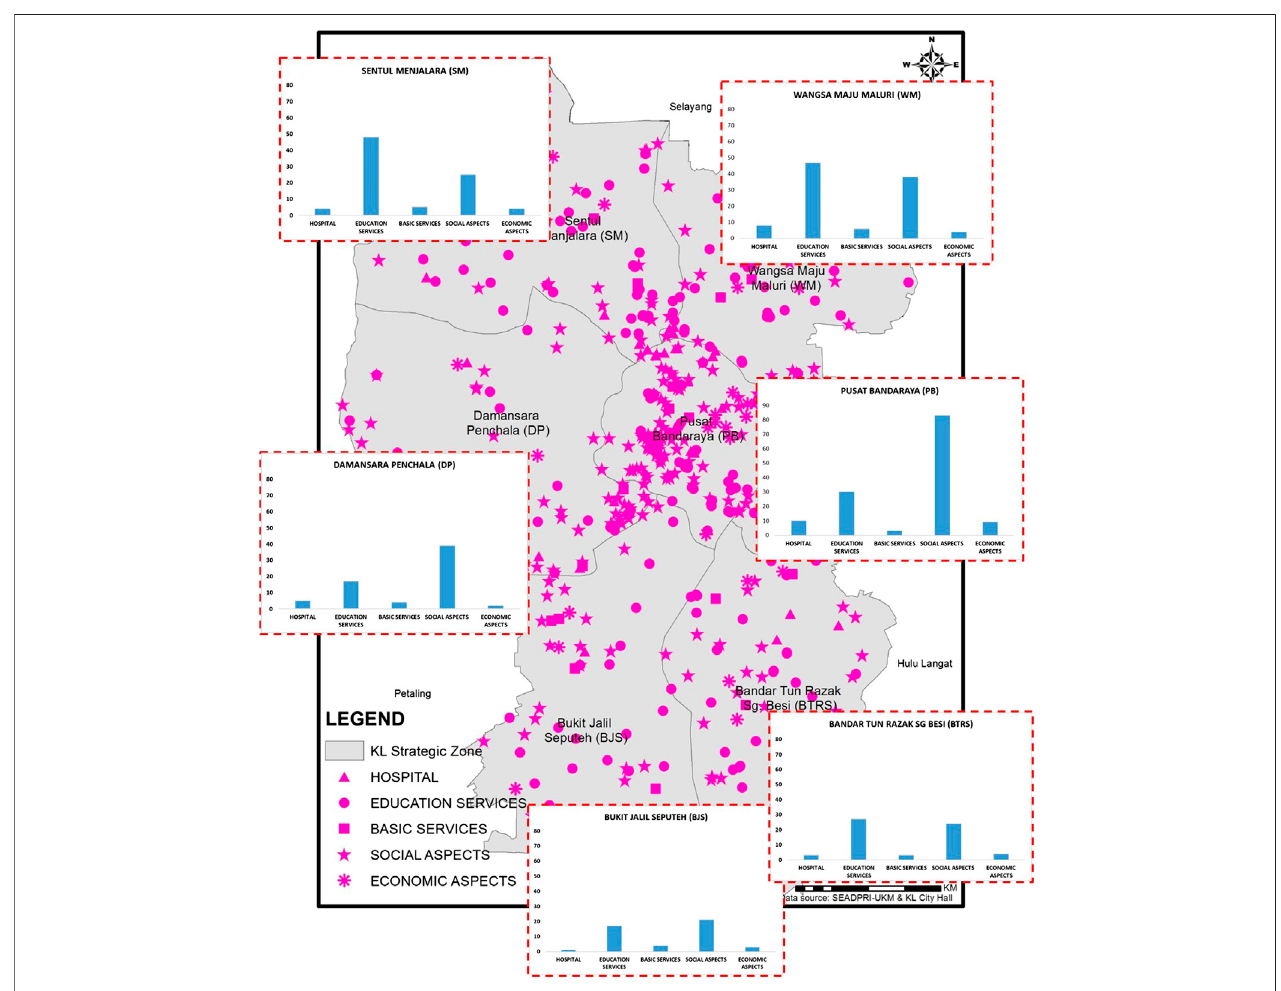
FIGURE 2 | Exposure elements in Kuala Lumpur developed from open source data. The height of the bar indicates the number of facilities in the various strategic zones of Kuala Lumpur.